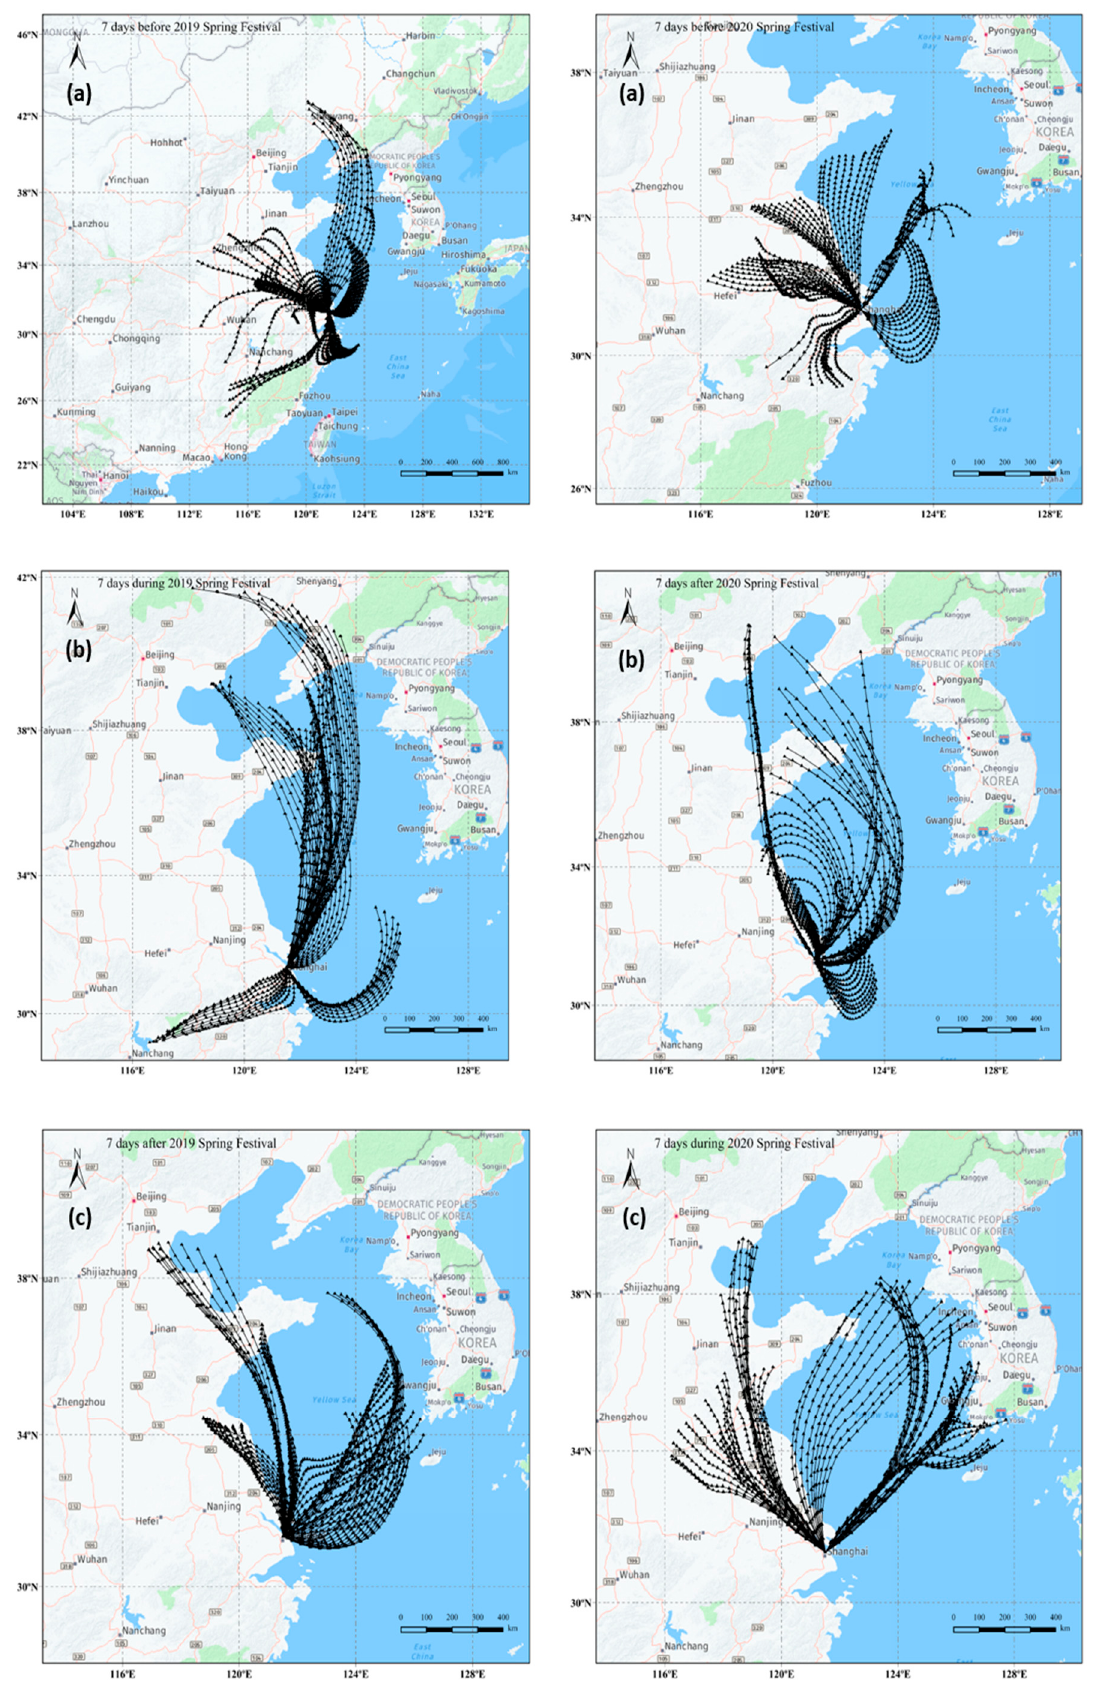
Figure 9. Clusters of backward trajectories ( a ) before, ( b ) during and ( c ) after the Spring Festival, 2019 and 2020.